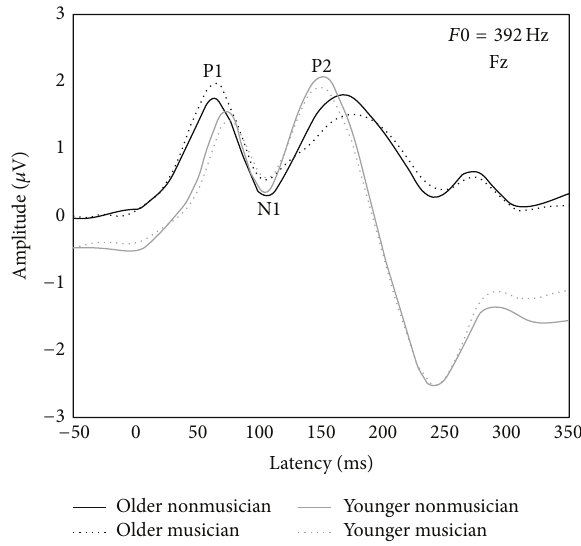
Figure 4: Group averaged CAEP waveforms from older (black lines) and young (gray lines) adult nonmusicians (solid lines) and musicians (dotted lines) illustrating P1-N1-P2 at Fz elicited by the standard harmonic tone ( 𝐹0 = 392